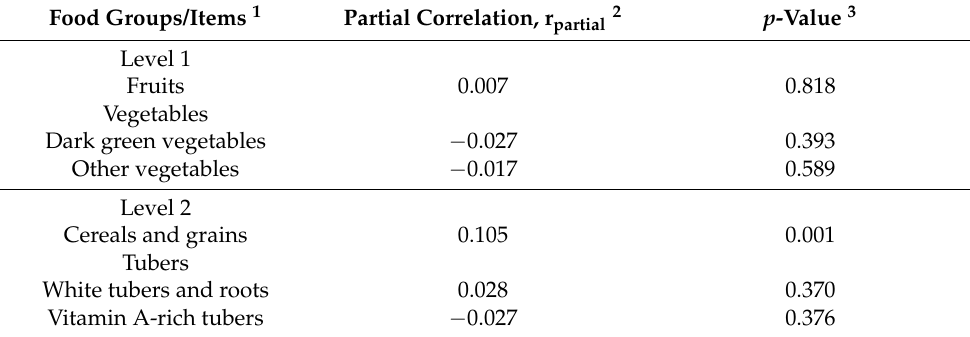
Table 3. Partial correlation between ∆ dietary intake patterns and weight gain during the COVID-19